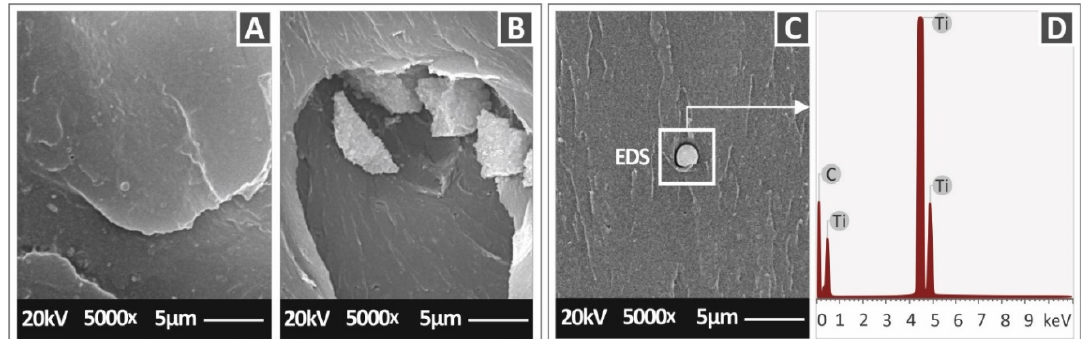
Figure 15. SEM images of the PC/TiC nanocomposites fracture surface: ( A ) 1 wt.% at 30×, ( B ) 1 wt.% at 300×, ( C ) 2 wt.% at 30×, ( D ) 2 wt.% at 300×, ( E ) 3 wt.% at 30×, ( F ) 3 wt.% at 300×, ( G ) 6 wt.% at 30×, and ( H ) 1 wt.% at 300×.